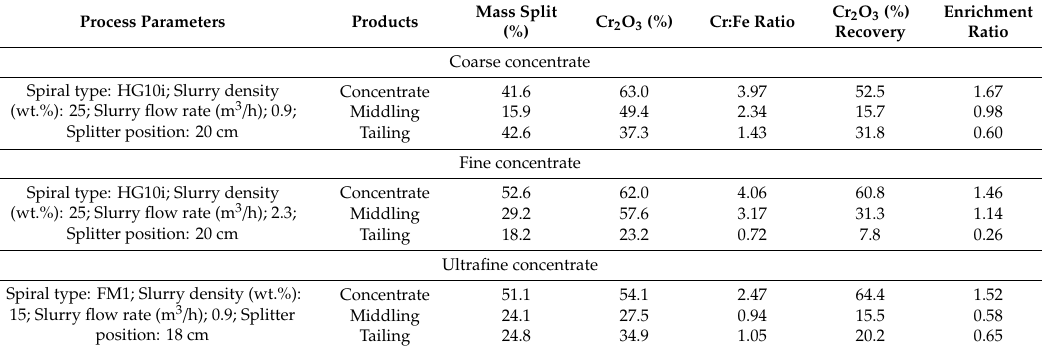
Table 6. Results of the optimum condition for enhancing Cr:Fe